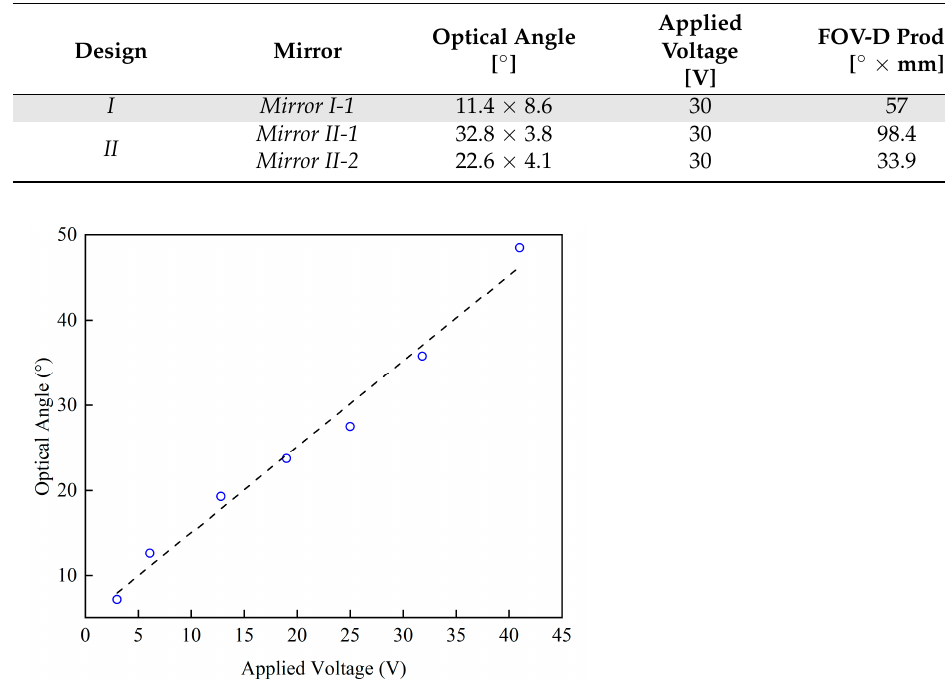
Figure 10. The dependence of the optical angle on the applied voltage for the fast axis of Mirror II-1.